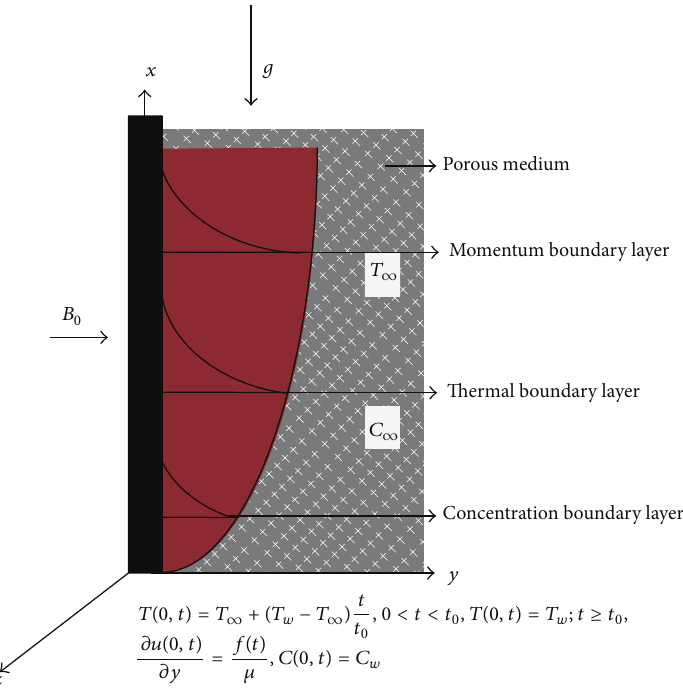
Figure 1: Physical configuration of the